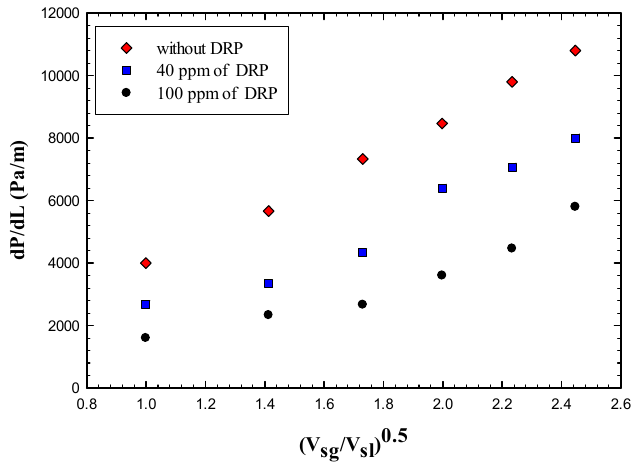
(Vsg/Vsl)0.5 Figure 12. Effect of drag reducing polymer on pseudo slug flow regime using a concentration of 40 and 100 ppm.